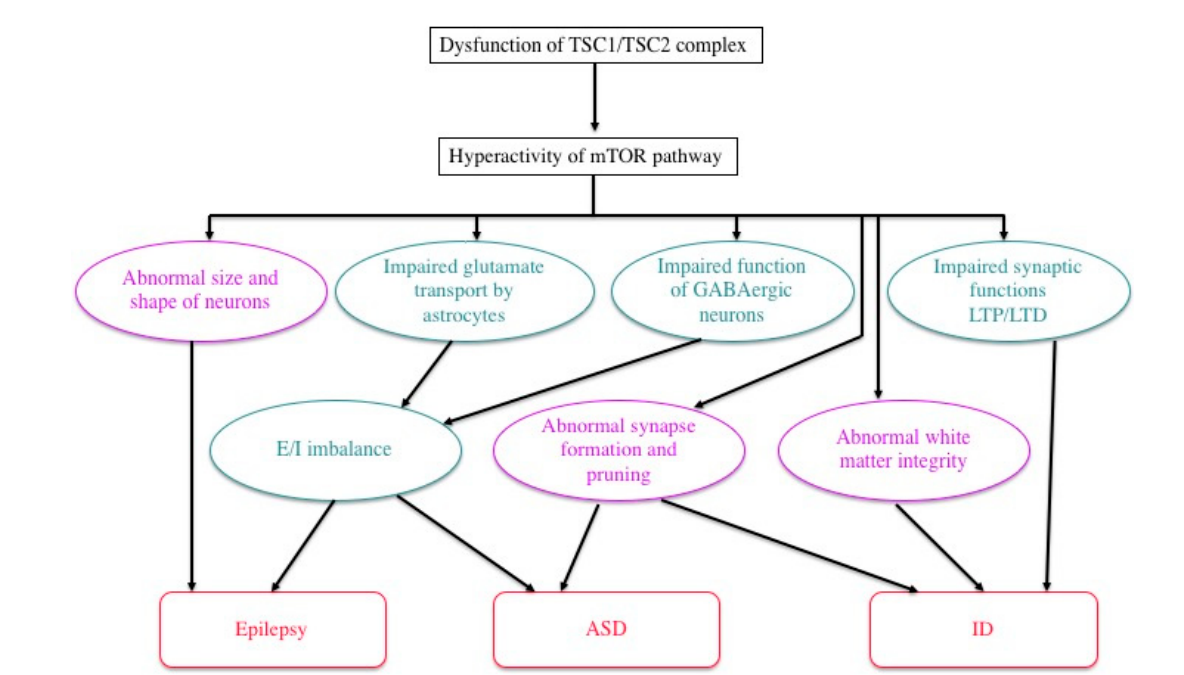
Figure 4. Possible mechanisms of TSC brain symptoms by which a loss of function of the TSC1/TSC2 complex causes a variety of structural (purple) and functional (green) abnormalities, leading to epilepsy, ID, and/or ASD (modified from Napolioni et al. (2009)